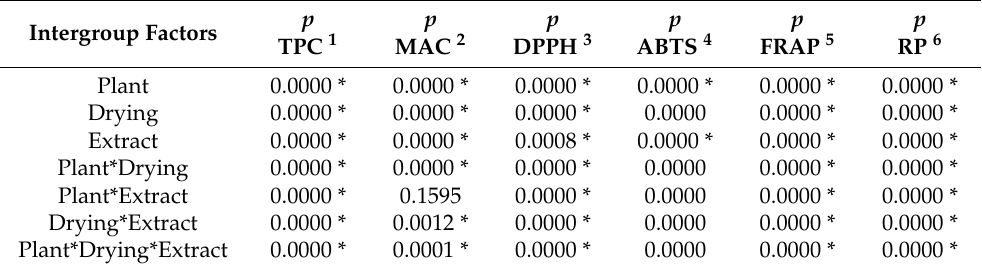
Table 1. ANOVA results for TPC, MAC, DPPH, ABTS, FRAP and RP in samples of red clover, sweet violet and elderberry flowers.